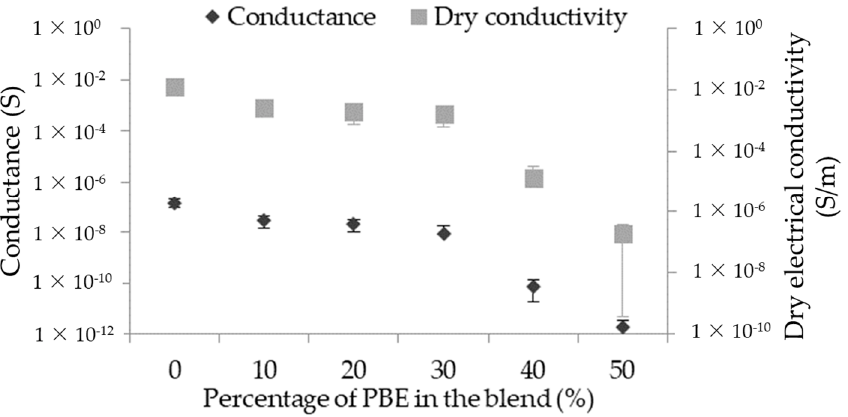
Figure 7. Influence of the proportion by weight of PBE on the short circuit signal of the PA6.6 3CNT /PBE blends.